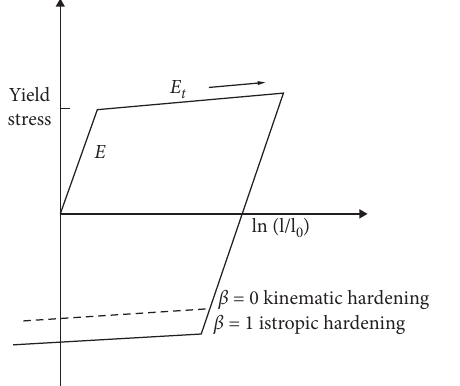
Figure 3: Stress-strain relationship of hardening material.